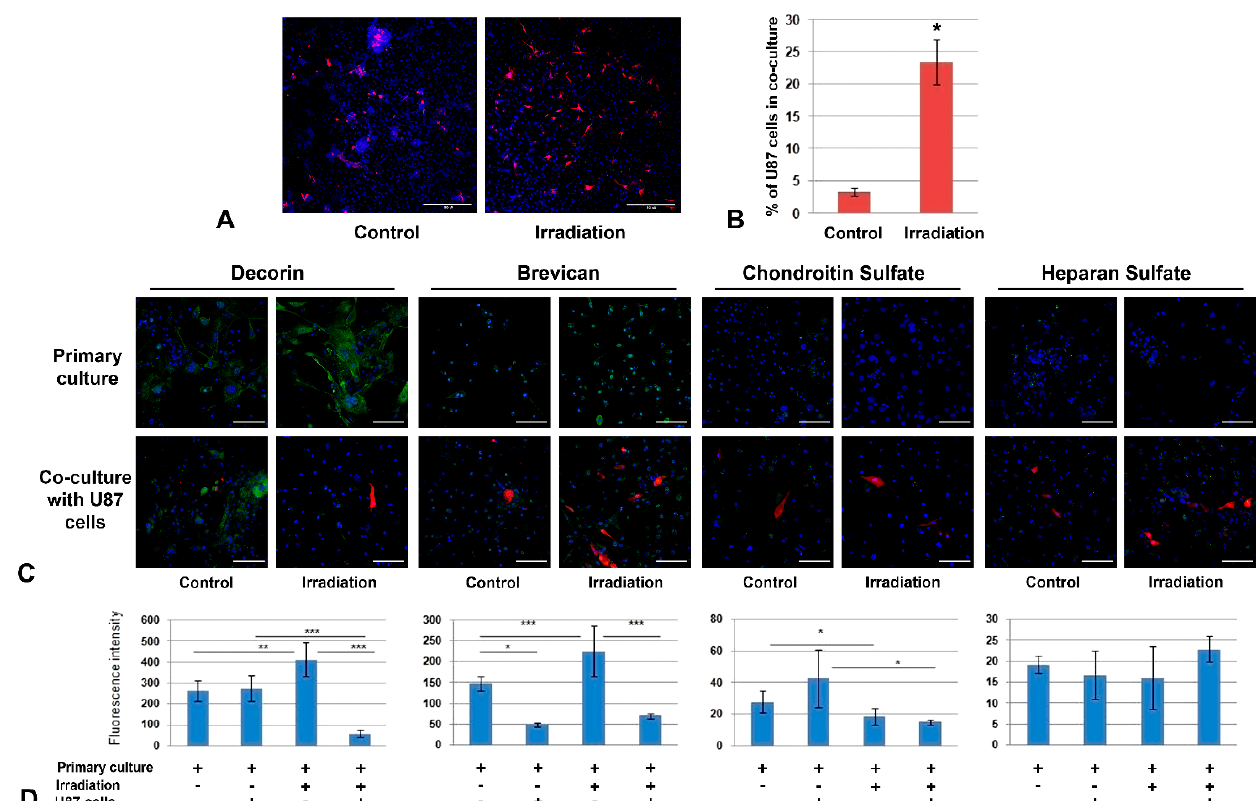
Figure 6. Co-culture of primary glial cultures from irradiated mouse brains with GBM cells. ( A ) Microphotograph of the co-culture of U87 GBM cells with glial cells from the control or irradiated brain tissues. Magnification × 200, scale bar 500 µ m. ( B ) Quantitative analysis of a number of U87 cells per 0.5 × 0.5 cm square (Zeiss LSM710 tile-scan + CellProfiler 4.1.3). * p < 0.05. ( C ) Immunofluorescence analysis of PG core proteins (decorin, brevican) and GAG content (CS, HS) in primary glial cells co-cultured with U87 GBM cells or triple-irradiated or both. Visualization of the studied antigens with Alexa Fluor 488 secondary antibodies (green), U87-RFP cells (red) and DAPI (blue). Magnification × 400, scale bar 100 µ m. ( D ) Quantitative analysis of the PG core proteins and GAG content in the glial cultures from control and irradiated mouse brain tissues (CellProfiler4.1.3. software). ANOVA, * p < 0.05, ** p < 0.01, *** p < 0.001.